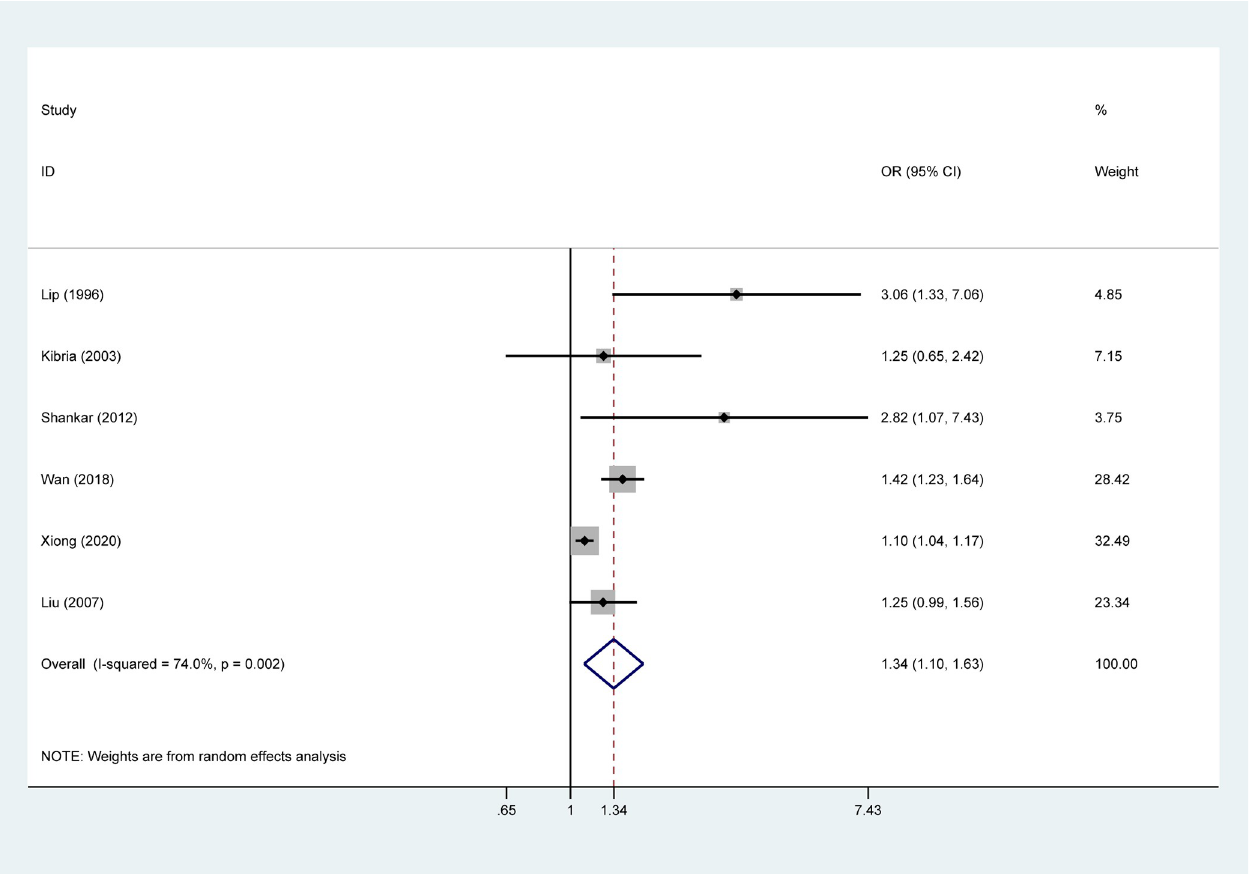
Fig 2. Forest plot of the pooled result between helicobacter pylori and hypertension.